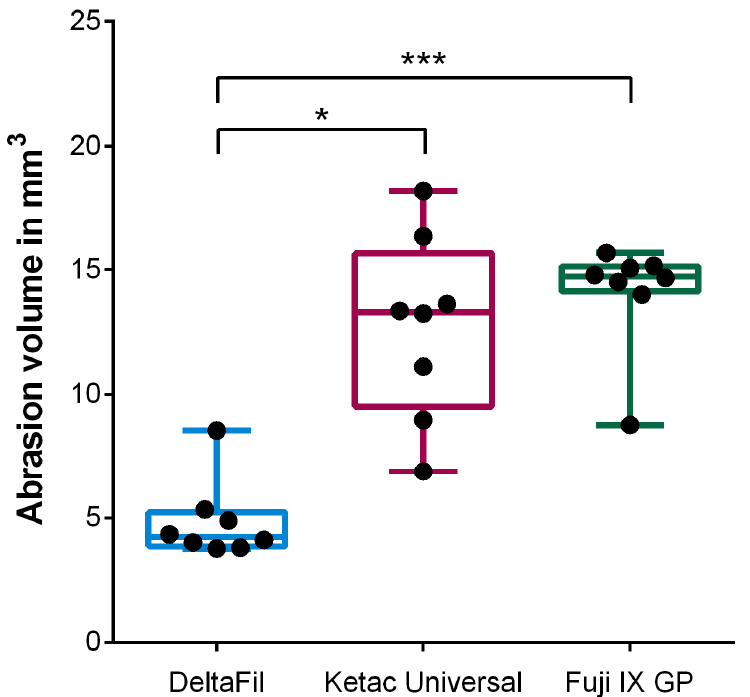
Figure 4. Abrasion volume of the restored teeth after termination of the chewing simulation. Restora- tions with DeltaFil resulted in a significantly decreased abrasion volume compared to Ketac Universal and Fuji IX GP (‘*’: p ≤ 0.05; ‘***’: p ≤ 0.001). The error bars represent the minimum and maximum values of the measured